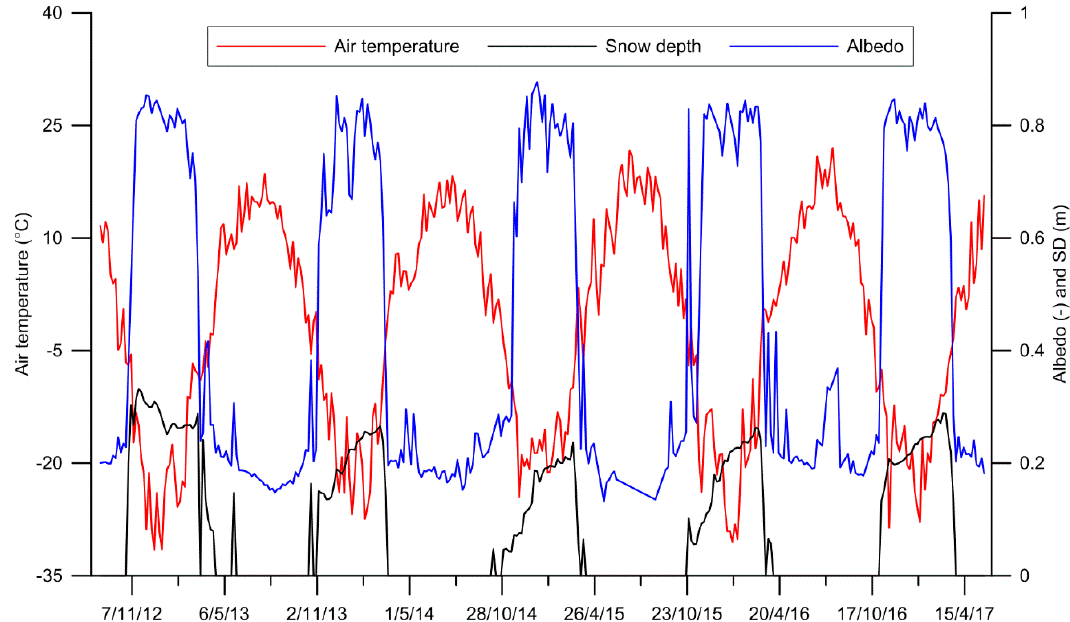
Figure 3. Snow depth (SD) collected from the SR50A-L sensor at the hydro-climatic station site by coupling with daily air temperature and albedo. The values are shown as 5-day averages.